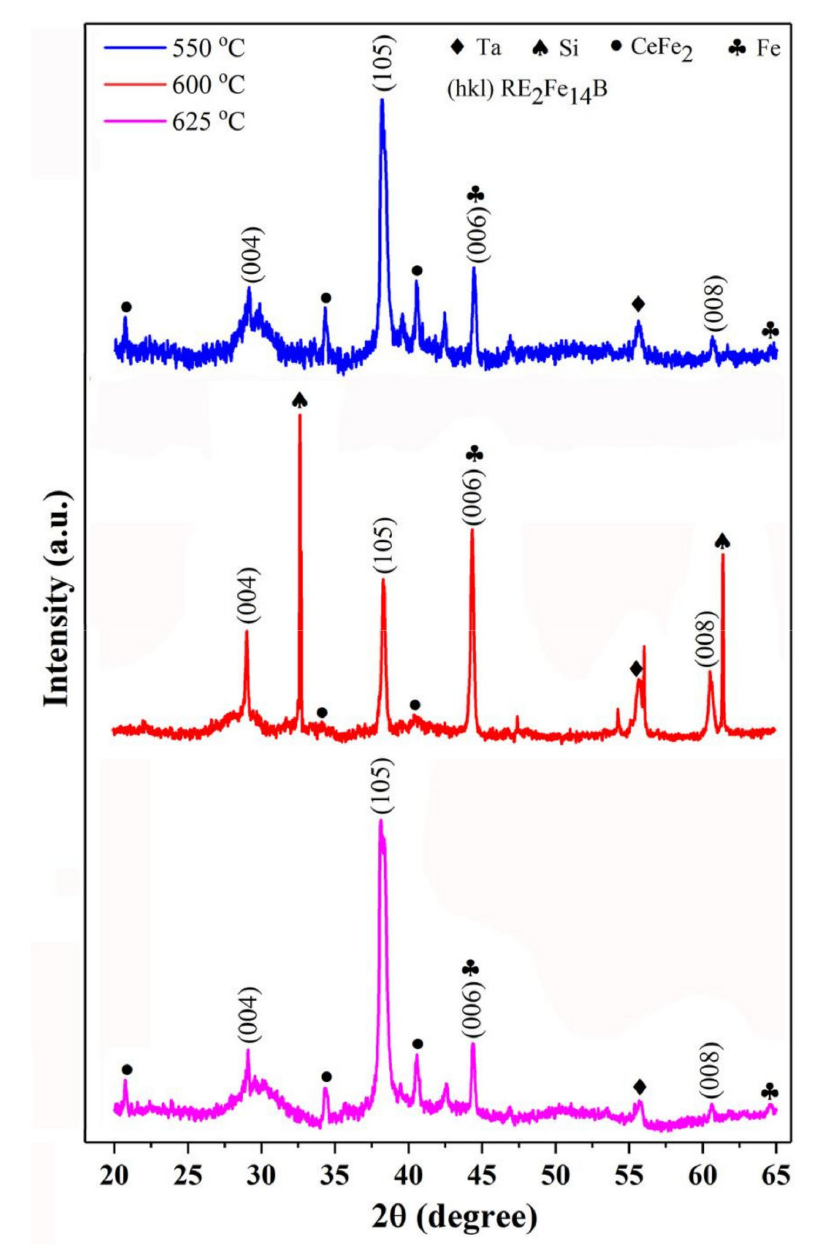
Figure 3. XRD patterns of Ta (50 nm)/Nd 6.19 Ce 7.98 Fe 75.48 B 10.35 (400 nm)/Ta (50 nm) films deposited at different